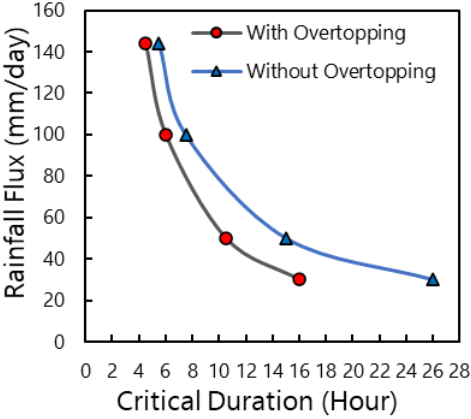
Figure 20. Critical duration under different rainfall infiltration.